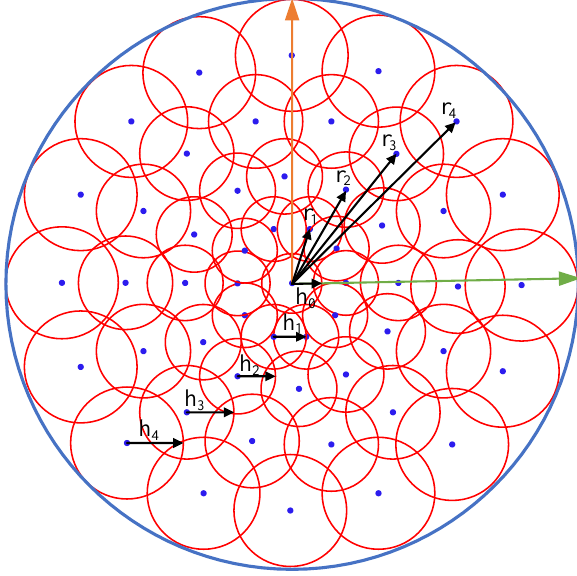
Figure 3. The schematic diagram of the retina-like sampling mode. In Figure 3, the blue dot represents the sampling point, the red circle represents the sampling area, the radius of the sampling circle of the same layer is the same, and the radius from the inside to the outside is h 0 , h 1 , . . . , h n ; the distance between the center of the sampling circle of the same layer and the origin of the local coordinate system is the same, and the distance from the inside to the outside is r 1 , . . . , r n ; n is the number of layers of the sampling circle; The number of sampling circles in each layer is N 0 , N 1 , . . . , N n and N 0 = 1. It is assumed that for a specific sampling point p sampling radius of h s is defined as C si = point in the sampling area impacts the feature description of the sampling point p